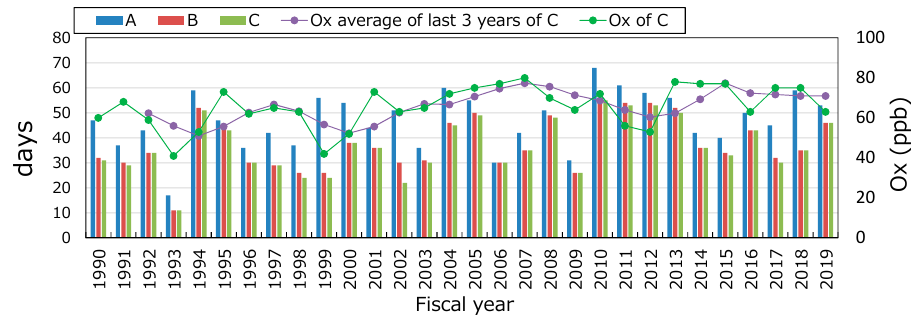
Figure 26. Number of days in patterns A, B, and C and trend over time in Ox. Selection conditions: A meets (1); B meets (1) and (2); and C meets (1), (2), and (3). Ox average of the past three years: This is the three-year moving average of the figure averaged for the number of extracted days of the average for all nine General sta. of the daily high of extracted-day hourly values. For example, the figure for 2007 is expressed as the three-year average for 2005–2007. Ox: figure averaged for the number of extracted days of the average for all nine General sta. of the daily high of extracted-day hourly values.